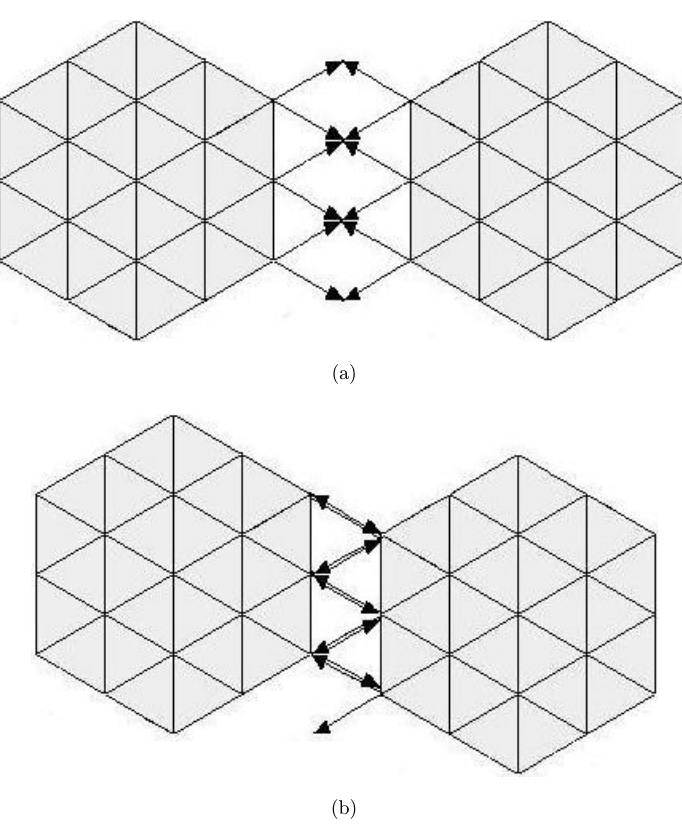
Fig. 6. Merge and aggregation of space changes caused by multiple